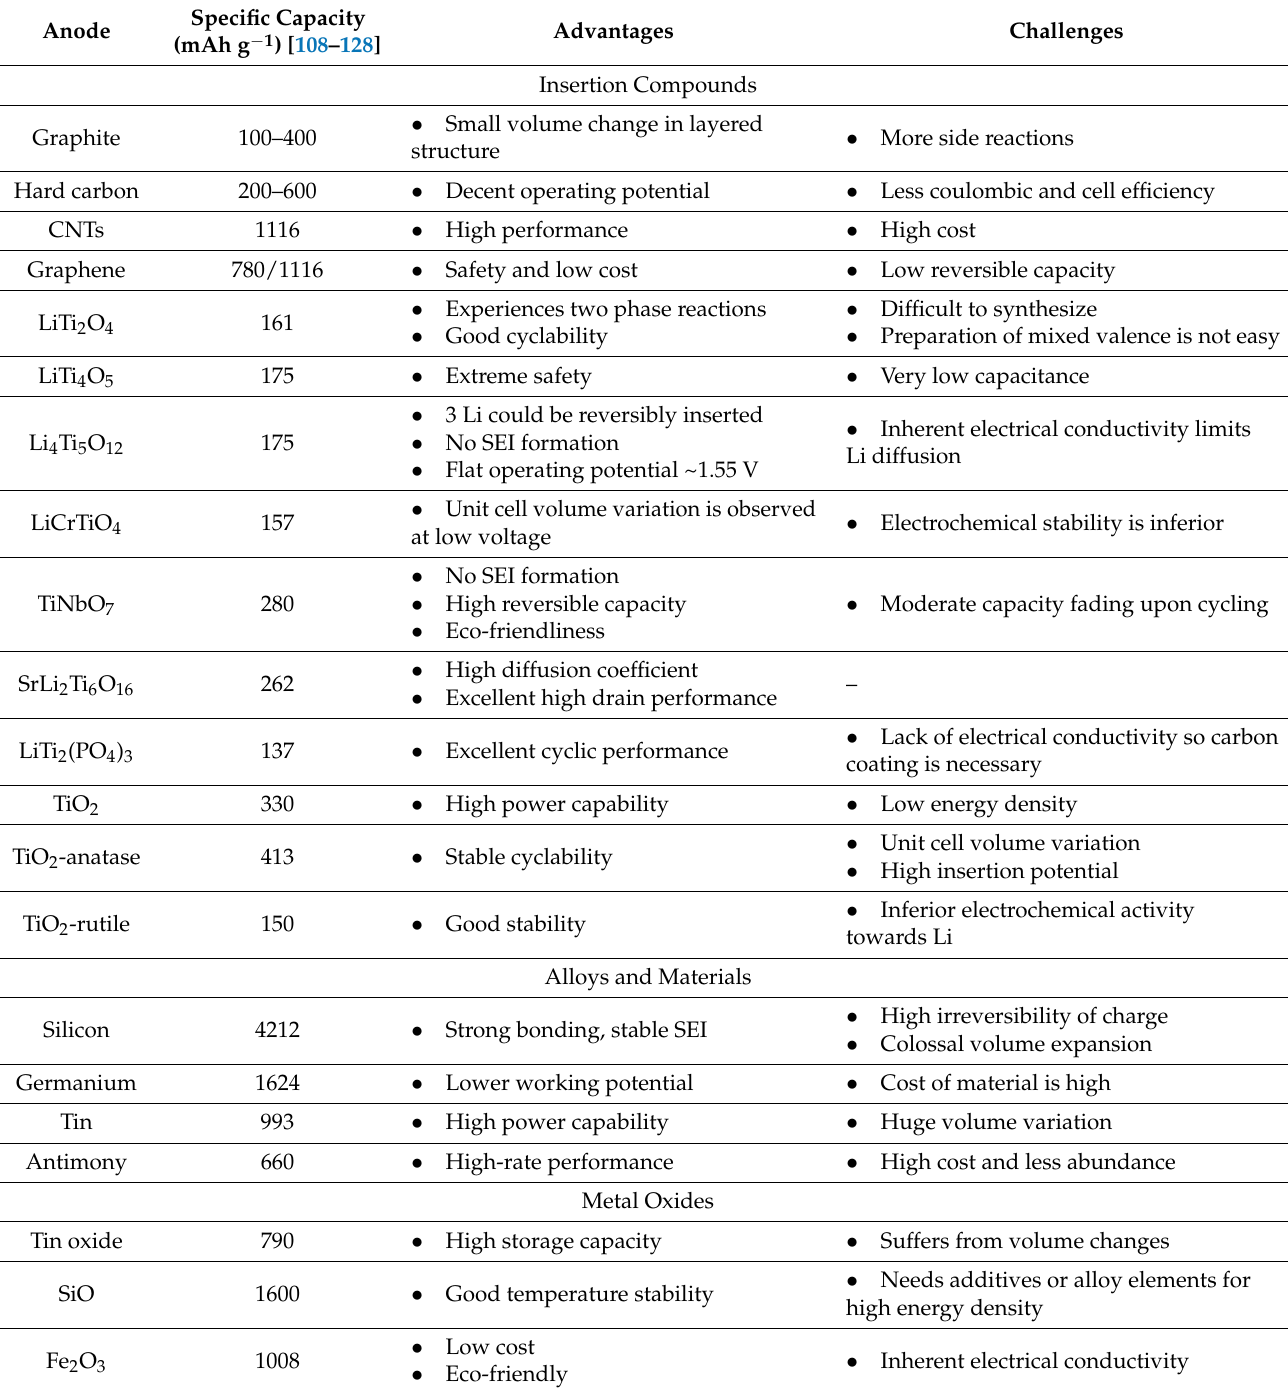
Table 2. Specific capacity, advantages, and limitations of common anodes in